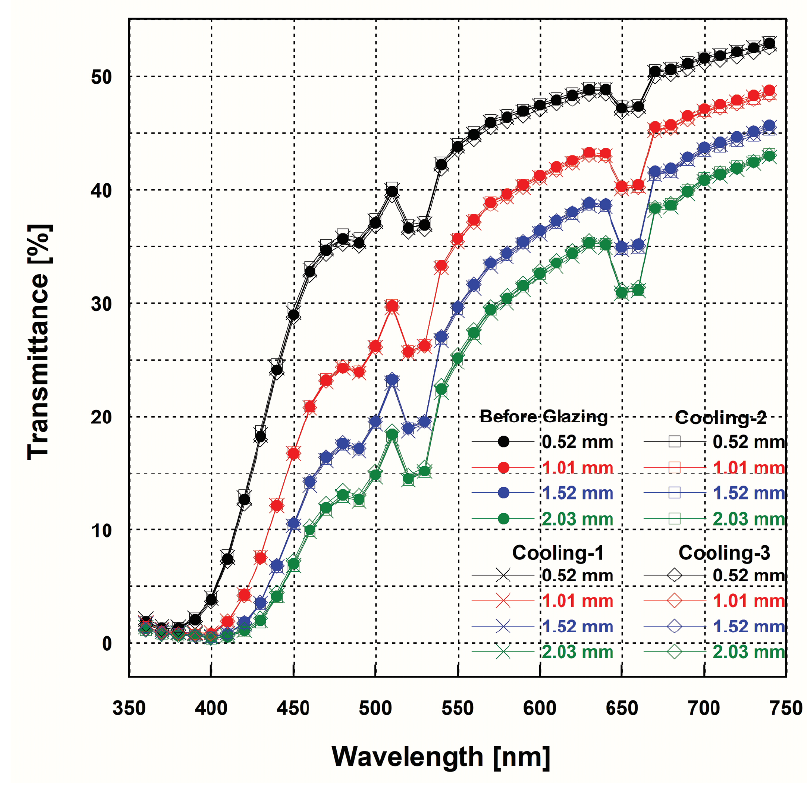
Figure 3. Spectral transmittance curves for each group of zirconia specimens. Table 4. Average transmittance (AT, %) for each group of the zirconia specimens with different thicknesses (mean ± SD).